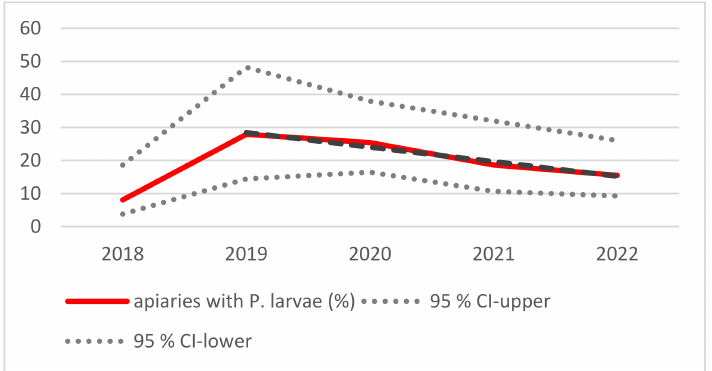
Figure 2. The percentage of apiaries with P. larvae detected (red line) and the 95% confidence interval (dotted grey lines). The dashed black line shows a linear declining trend for the years 2019–2022 (y = − 4.4 * x + 32.9; R 2 = 0.97, where x = duration in years, and y = the percentage of